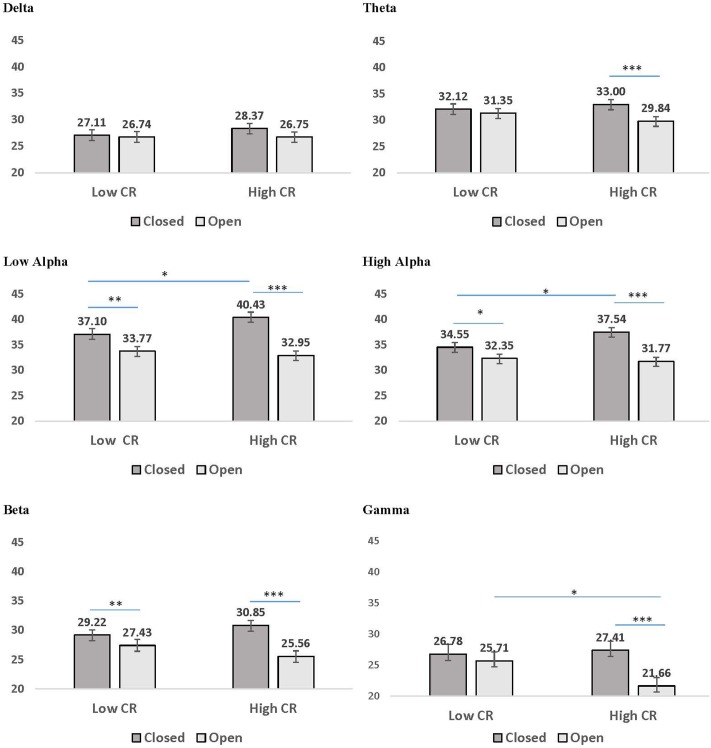
Mean coherence in low CR and high CR participants for eyes-closed (dark gray bars) and eyes-open (light gray bars) recording conditions. Error bars reflect the standard error for each condition. Lines connect conditions that differ significantly from each other, with the endpoints of each line over the middle of the bars for conditions that differ significantly from each other during pairwise comparisons. ∗p < 0.05, ∗∗p < 0.01, ∗∗∗p < 0.001.